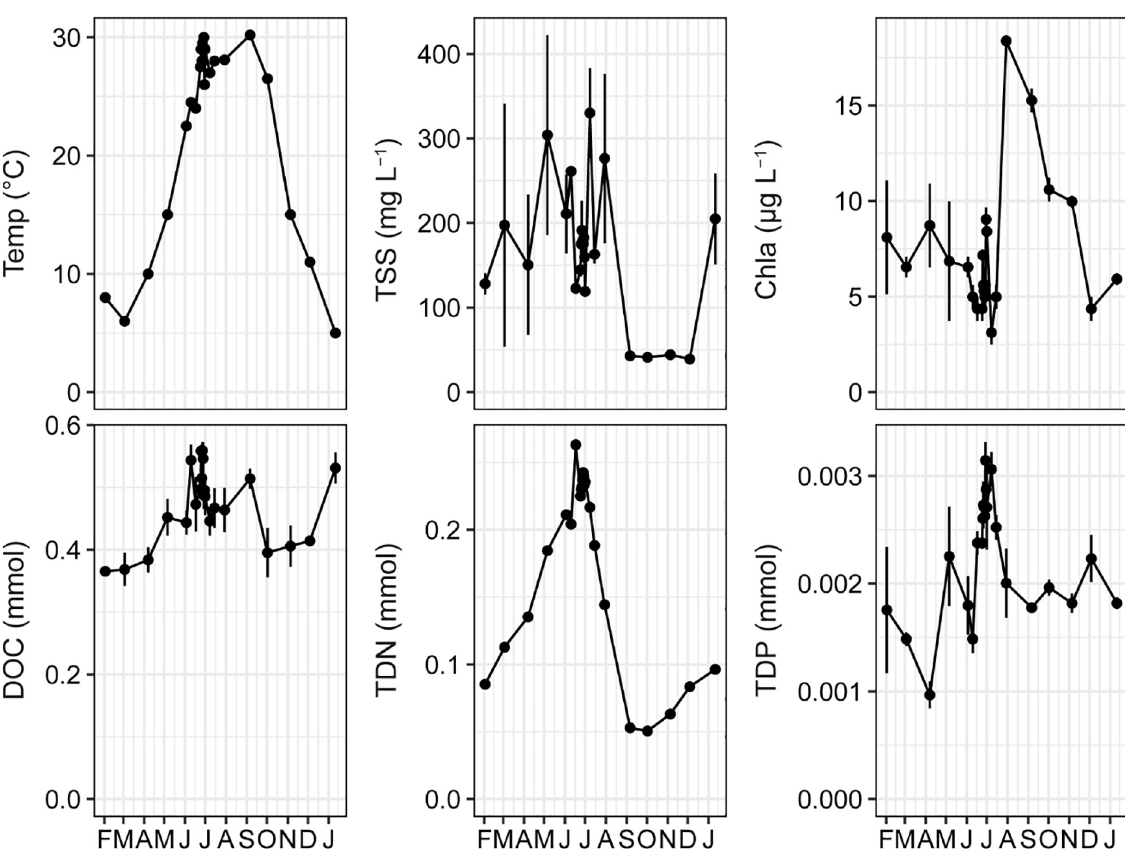
Fig 2. Environmental variables measured in Lower Mississippi River water between February 2013 and January 2014. Abbreviations: Temp, water temperature; TSS, total suspended solids; Chla, chlorophyll a ; DOC, total dissolved organic carbon; TDN, total dissolved nitrogen; TDP, total dissolved phosphorus. Except for water temperature, parameter measurements are presented as means ( ± SE) for each date, n = 2–3. For clarity, sample dates are connected by lines. These lines are not intended to convey patterns of variation at shorter time intervals than what is